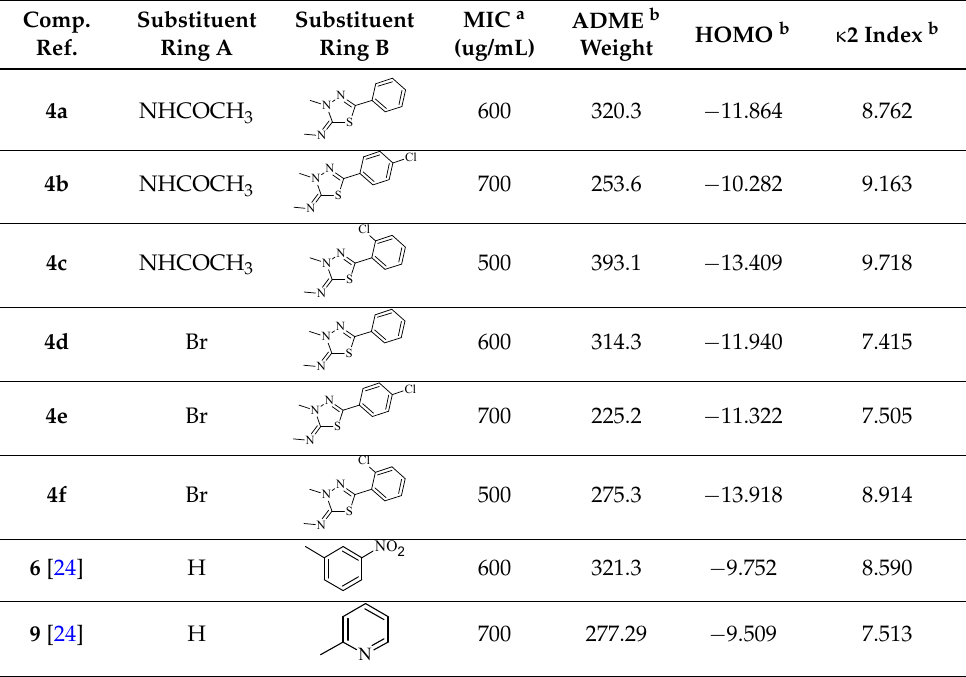
Table 2. Rationalization of the synthesized Chalcones 4 as antibacterial agents using quantum chemical computation. Comp.